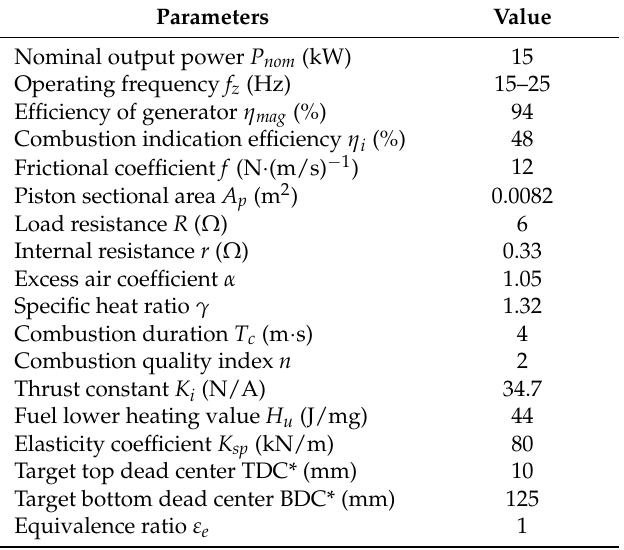
Table 1. The key geometric and performance parameters of